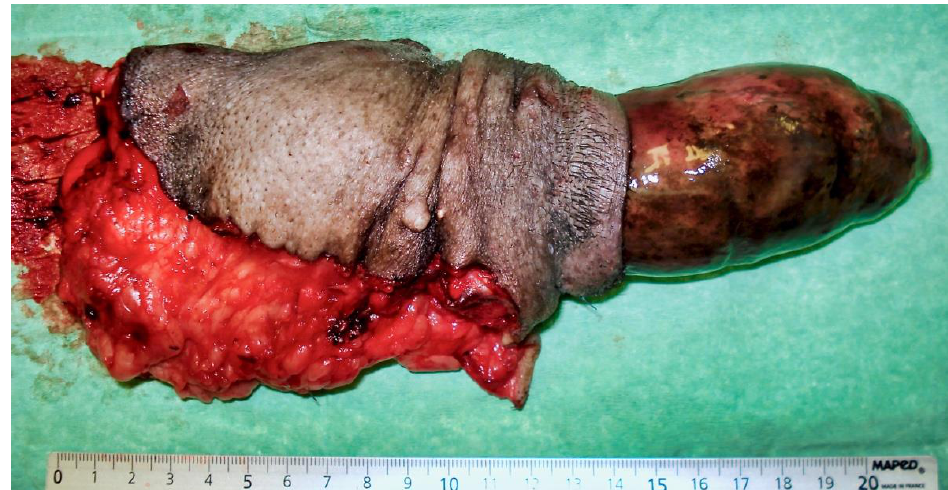
Figure 6. Resected specimen with the sheath still partially covering the penis.